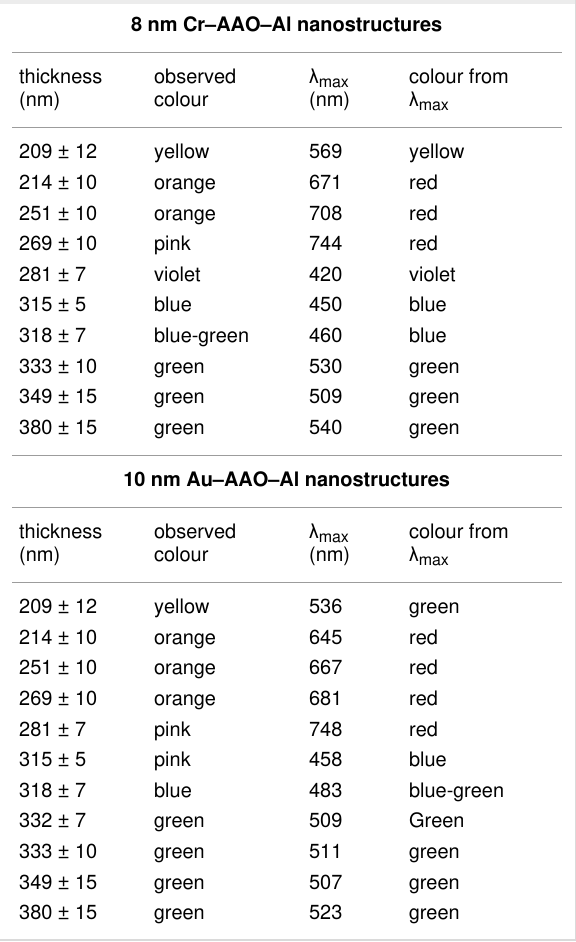
Table 1: AAO thickness, observed colour, wavelength of maximum reflectance, and colour obtained from the wavelength for 8 nm Cr–AAO–Al and 10 nm Au–AAO–Al nanostructures. 8 nm Cr–AAO–Al